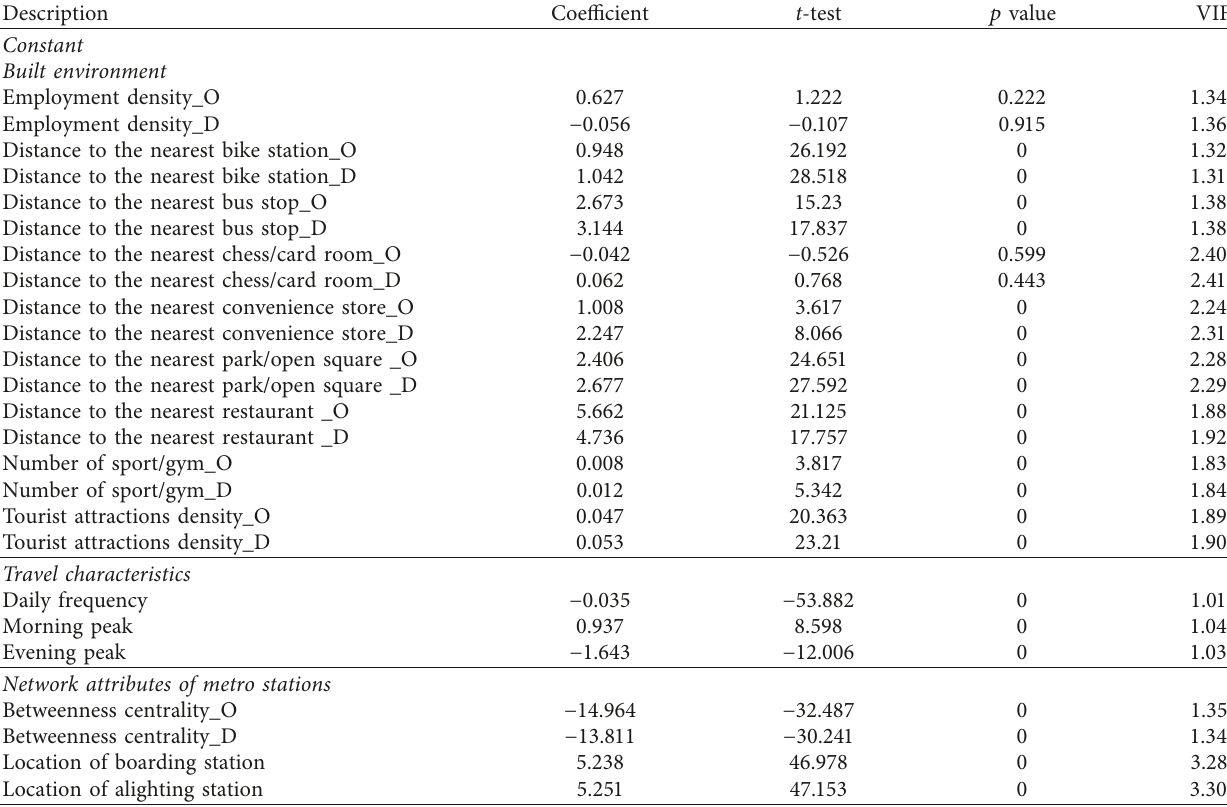
Table 4: Linear regression model